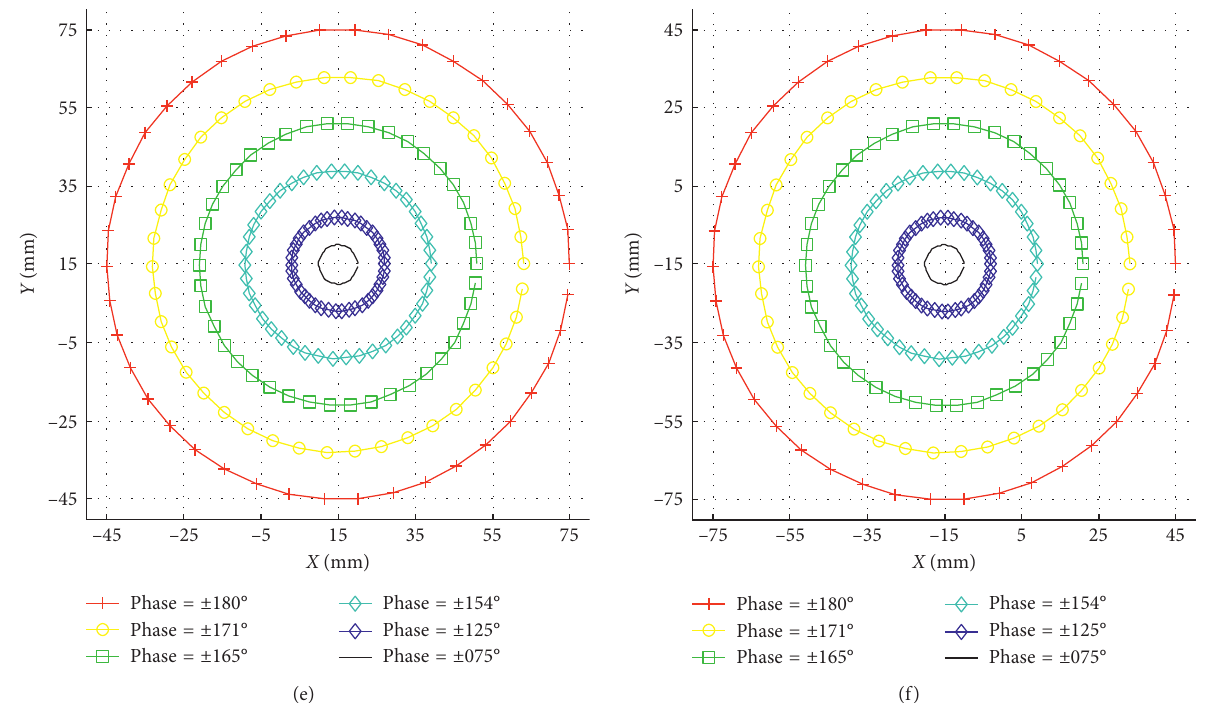
Figure 4: Required reflection phase curves for a planar reflector (8 × 8 elements) (a) with different feed positions, (b) f � f